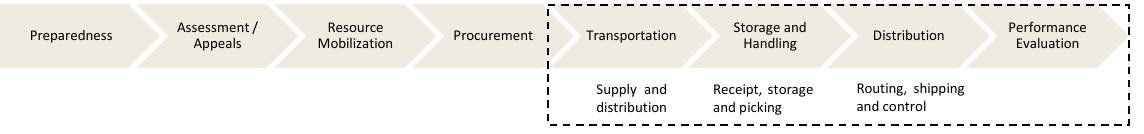
Figure 1. Scope of the study in humanitarian supply chain (Source: Adapted from Thomas (2003)).